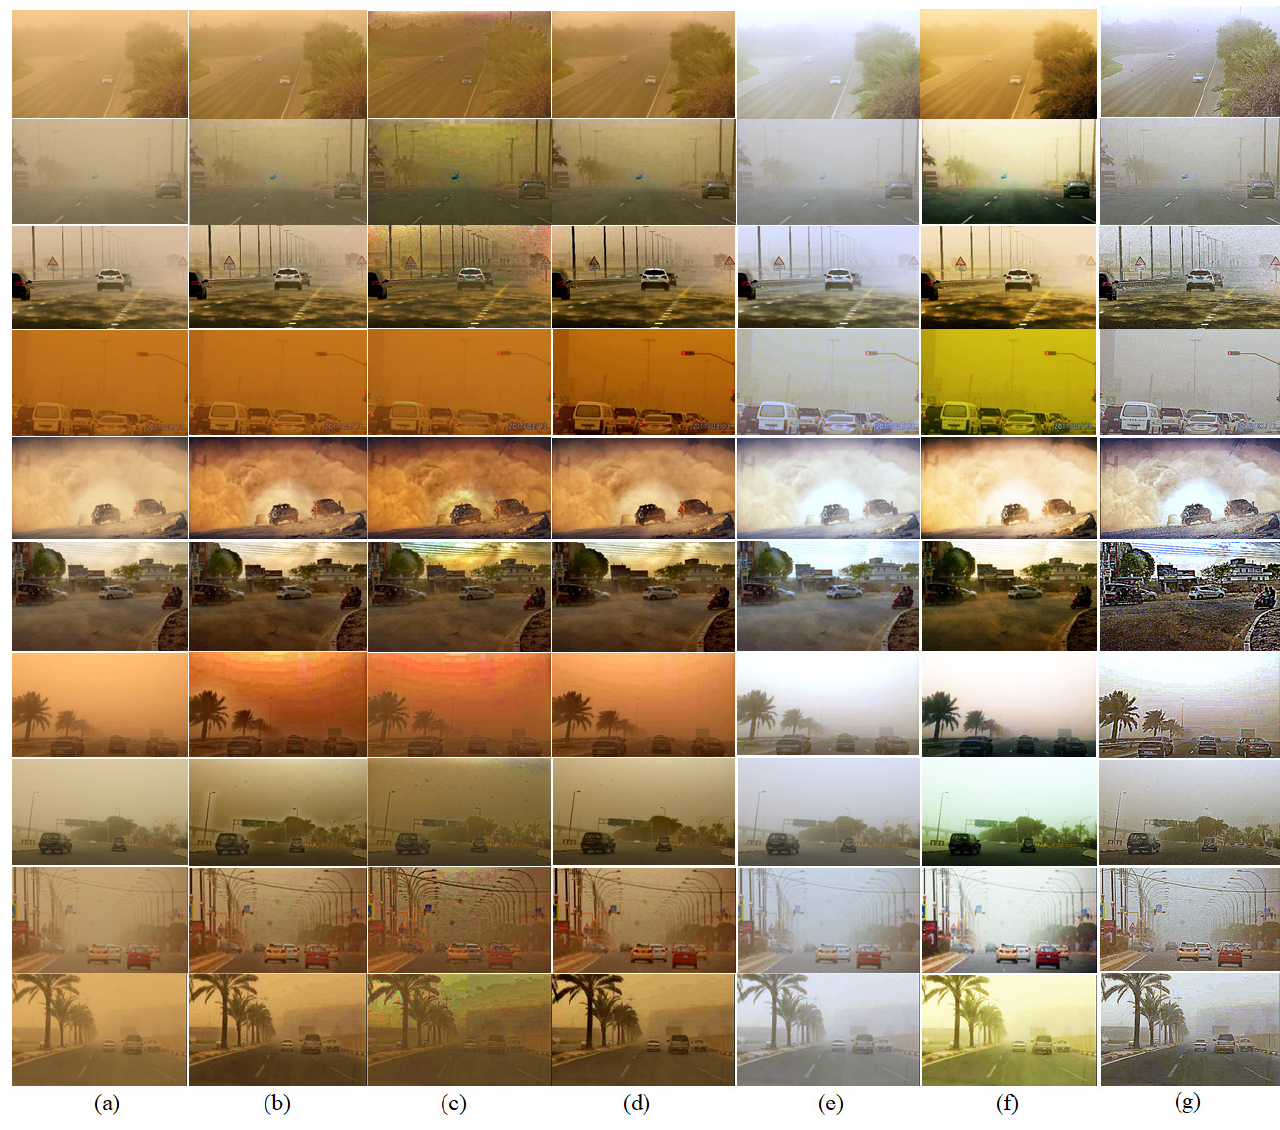
Figure 6. The comparison of the enhanced image with state-of-the-art methods and the proposed method on lightly degraded duststorm images: ( a ) Input image; ( b ) He et al. [1]; ( c ) Meng et al. [2]; ( d ) Ren et al. [15]; ( e ) Gao et al. [7]; ( f ) Al Ameen [4]; ( g ) Proposed method.